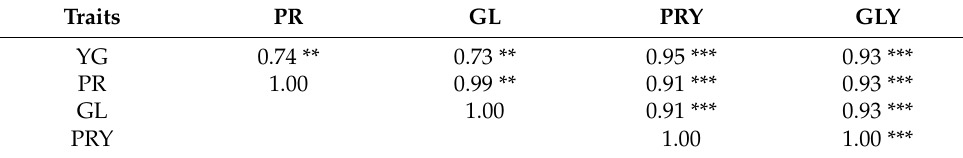
Table A1. Correlation matrix of basic properties of winter wheat and grain yield ( n = 28).